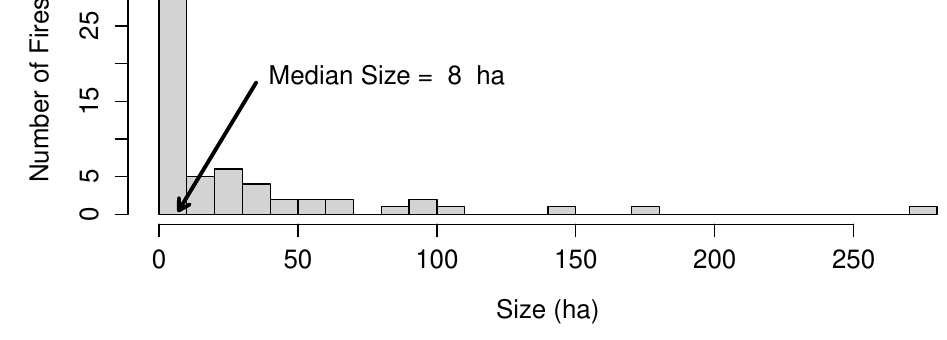
Figure 4. Distribution of unrecorded burn sizes.